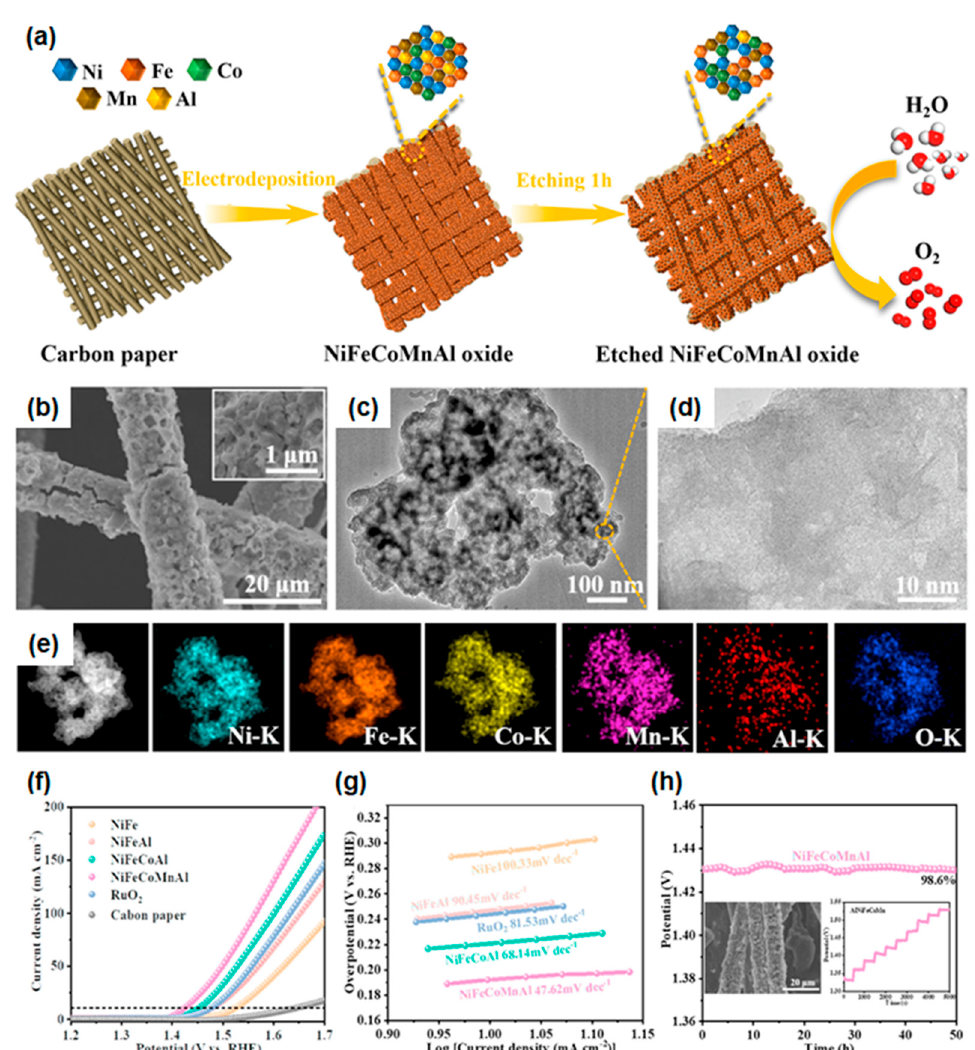
Figure 8. ( a ) Schematic illustration of the synthetic procedures for nanoporous NiFeCoMnAl oxide grown on carbon paper. ( b ) SEM and ( c , d ) TEM images of NiFeCoMnAl after soaking in 1.0 M KOH. ( e ) EDS elemental mapping of Ni, Fe, Co, Mn, Al, and O for etched NiFeCoMnAl. ( f ) LSV polarization curves and ( g ) Tafel plots of catalysts. ( h ) Stability of Ni-FeCoMnAl (NiFeCoMnAl loading: 0.35 mg/cm 2 ). Reprinted (adapted) from [148], copyright (2023) Elsevier B.V.